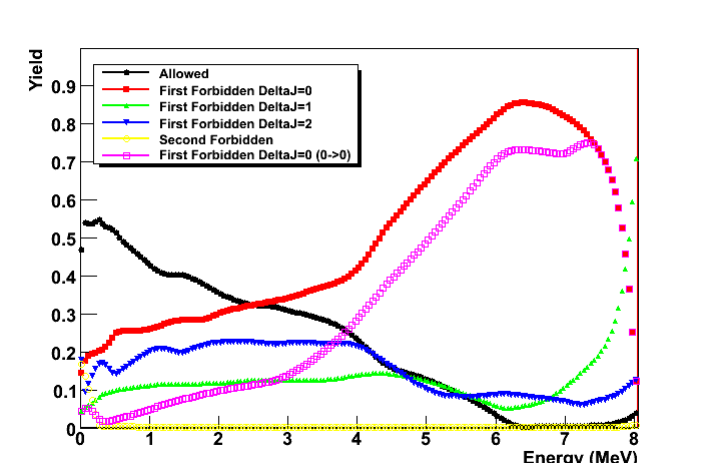
Figure 1. Contributions of di ff erent transition types determined from the ENSDF data base [22] in the electron- energy spectrum calculated for the fission of 235 U induced by thermal